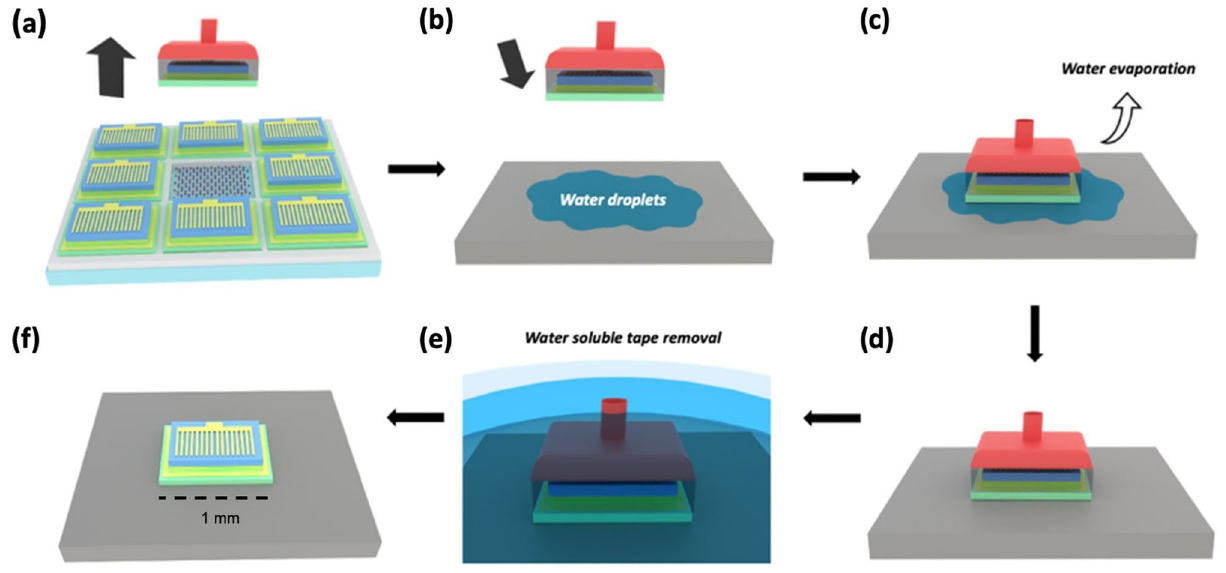
Figure 5. Schematics of the lift-off and van der Waals bonding transfer on rigid substrate. ( a ) Vertical release from hBN/sapphire native substrate ( b ) water droplets deposition of silicon ( c ) deposition of released LEDs onto